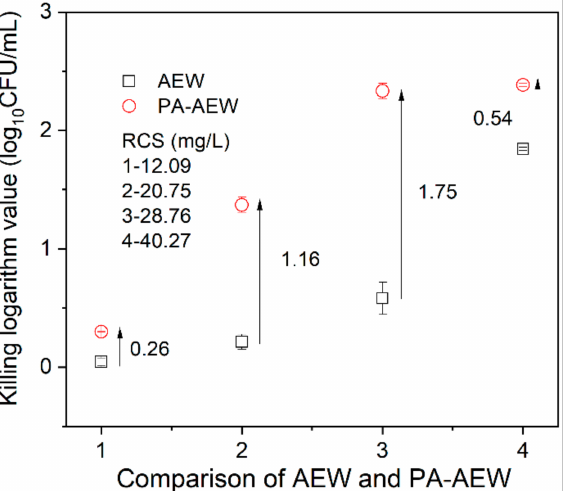
Figure 6. Comparison of sterilization efficiency of AEW and PA-AEW with different RCS on the bacterial suspension of B. subtilis